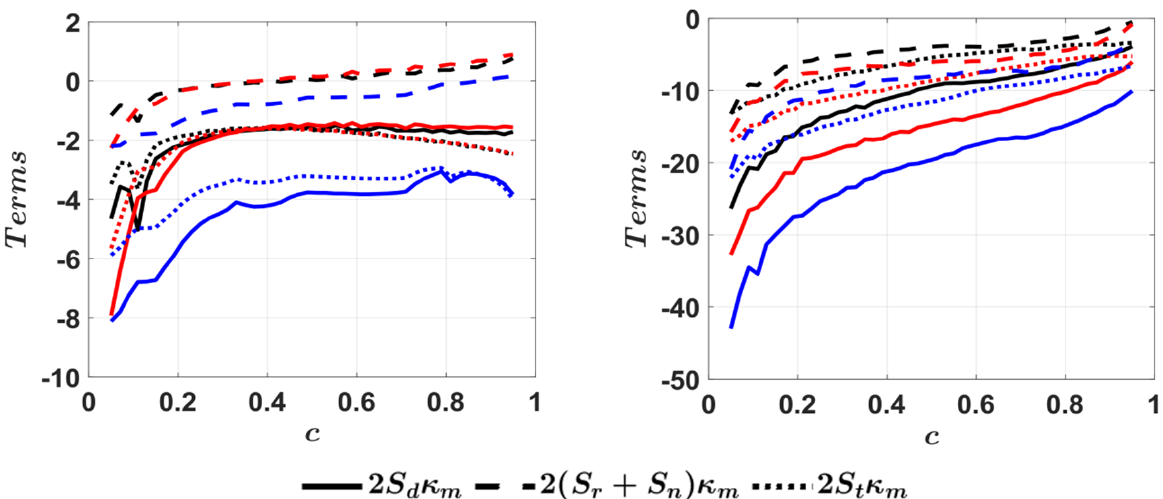
Figure 11. Profiles of the normalised mean values of the additional flame tangential strain rate due to flame propagation (2 S d κ m × δ th / S L ) and its components (i.e., 2 ( S r + S n ) κ m × δ th / S L and 2 S t κ m × δ th / S L ) conditioned upon c for u (cid:48) / S L = 4.0 (black) 6.0 (red) and 8.0 (blue) for statistically planar turbulent premixed flames (first column) and homogeneous MILD combustion cases (second column).